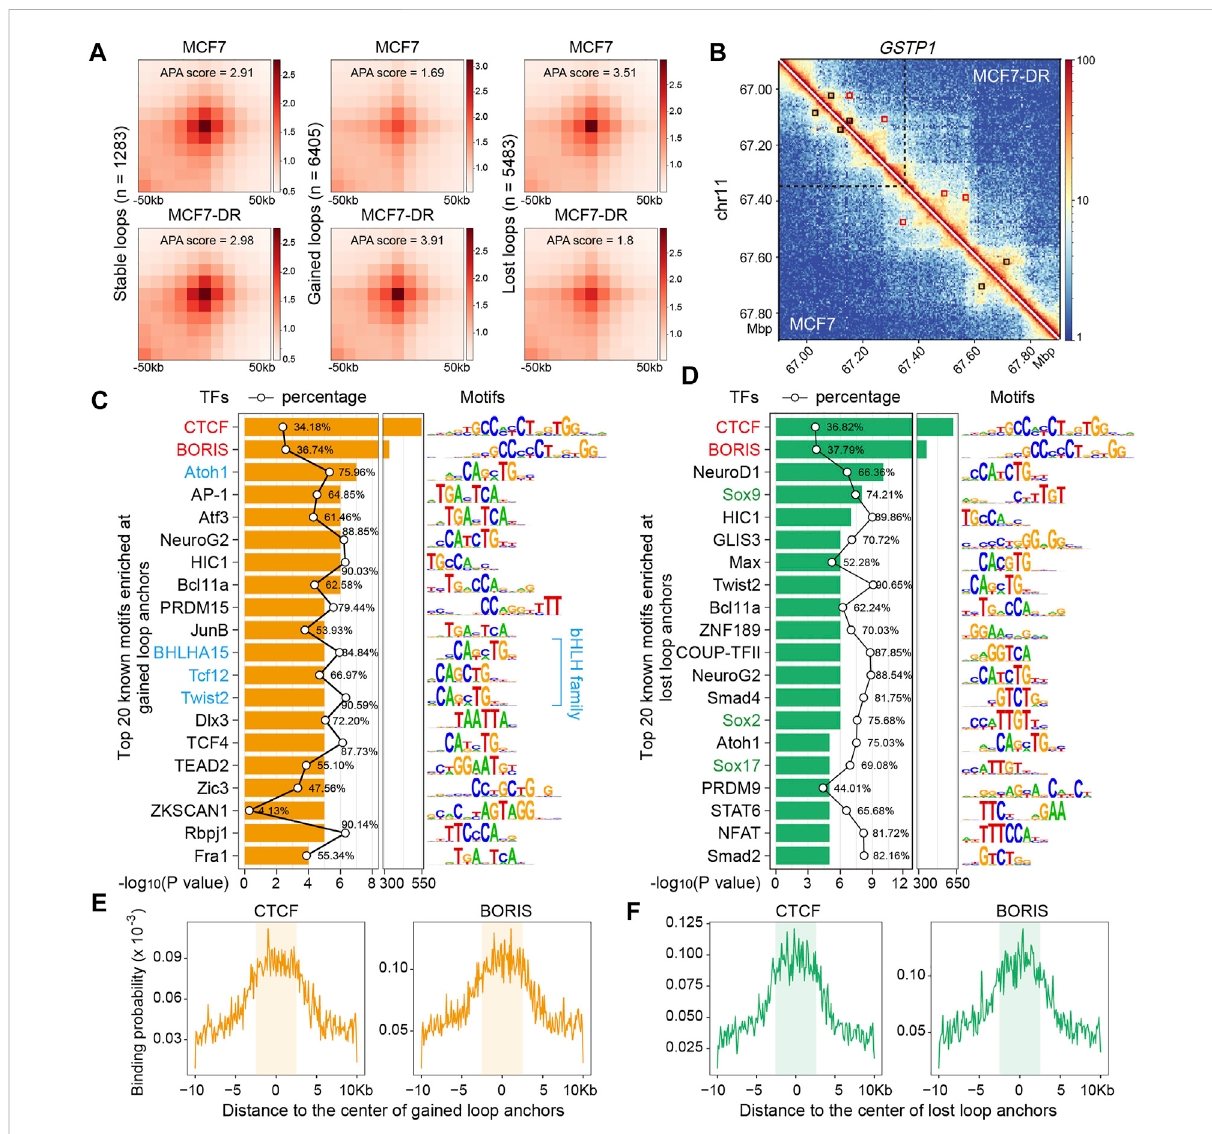
FIGURE 4 Transcription factor families potentially involved in chromatin loop changes. (A) Aggregate peak analysis (APA) plots measuring the aggregate strengthofthestable( n =1283),gained( n =6405)andlostloops( n =5483).APAscorewascalculatedwithHiCPeakssoftwareusingHi-Cmatrixdata at 5-kb resolution. (B) Heatmap depicting an example of differential chromatin loops (at 5-kb resolution) between MCF7 (lower left) and MCF7-DR (upperright)onchr11:66900000 – 67900000. The blackboxesrepresentthestable loopsthatare present inboth celllines, while theredboxes denote the gained or lost loops in each cell line. The black vertical dashed lines indicate the GSTP1 locus. (C,D) Top 20 known TF motifs enriched at gained (C) and lost (D) loop anchors. The p values for motif enrichment were calculated by the HOMER software, and a p value less than 0.01